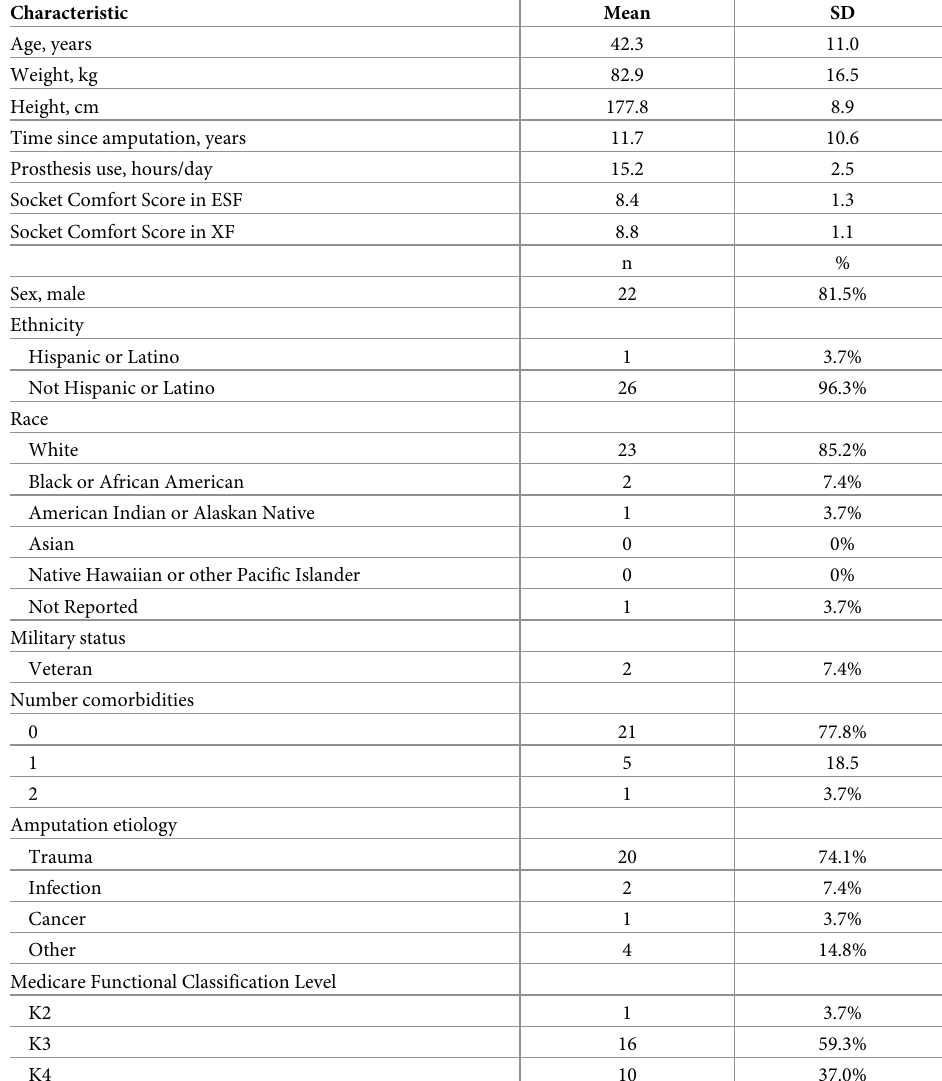
Table 1. Participant demographics and characteristics (n =